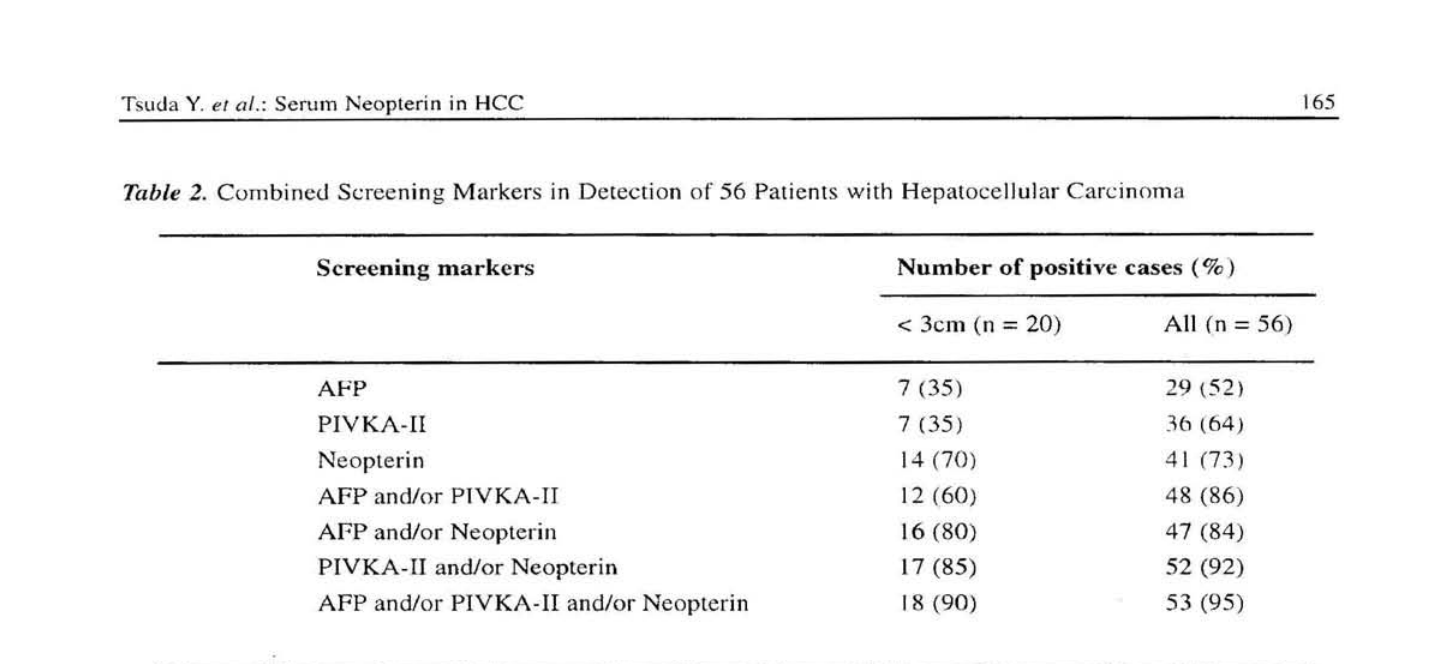
Table 2. Combined Screening Markers in Detection of 56 Patients witii Hepatocellular Carcinoma Screening markers